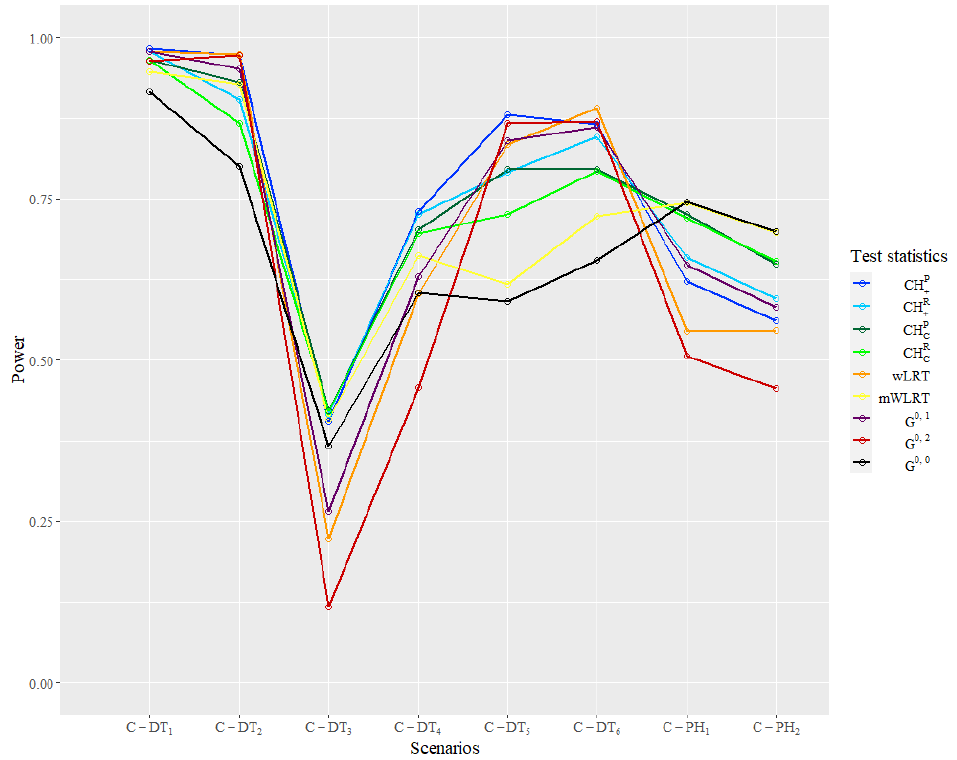
Figure 6. Empirical power of tests in clinical trial settings.